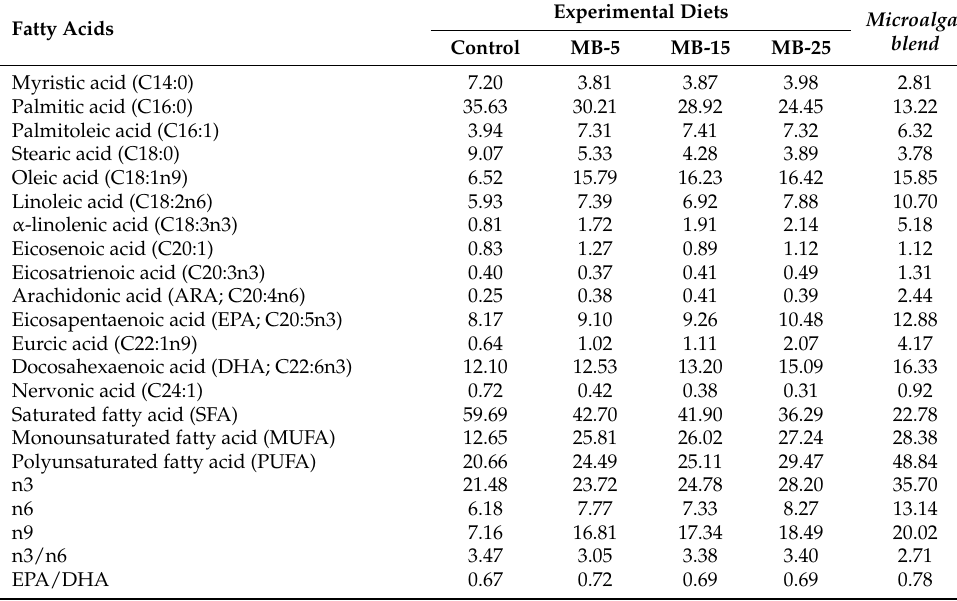
Experimental Diets Microalgae